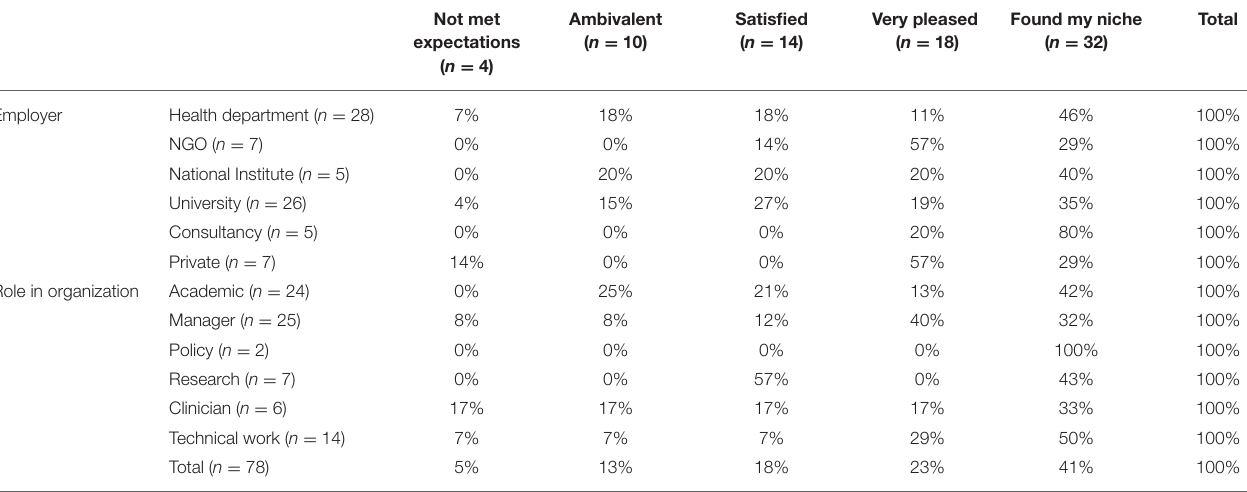
TABLE 1 | Respondents’ job satisfaction, by employers and work roles ( n =